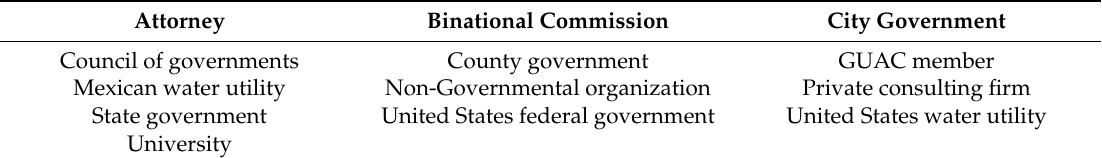
Table 1. Categories of stakeholders present at case study